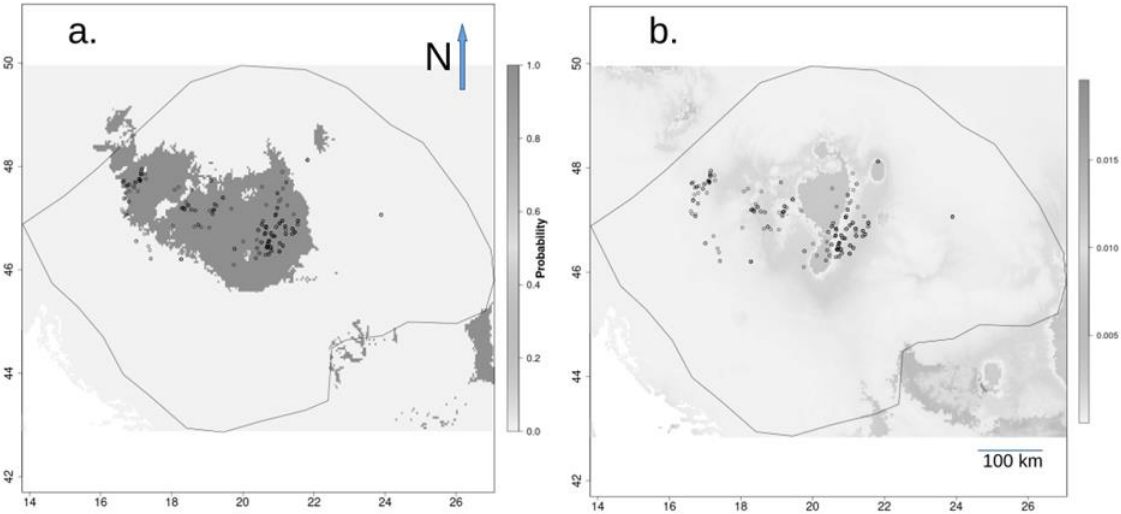
Figure 2. Predicted distribution ranges of the Great Bustard for ( a ) historical and ( b ) future time periods, projected using MaxEnt models fitted on occurrence locations of the study species within the Carpathian Basin. The dots indicate occurrences, the black line represents the Carpathian Basin, whereas the grey polygons show the potential presence of the Great Bustard, the grey color scale of which indicates presence probabilities.